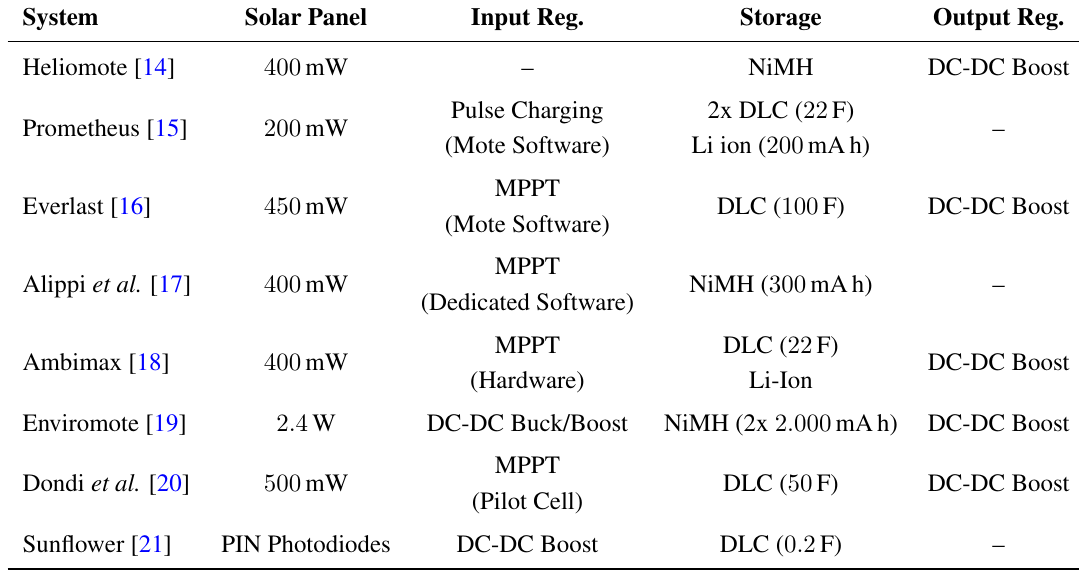
Table 1. Overview of solar energy harvesting system implementations. DLC, double-layer capacitor; MPPT, maximum power point